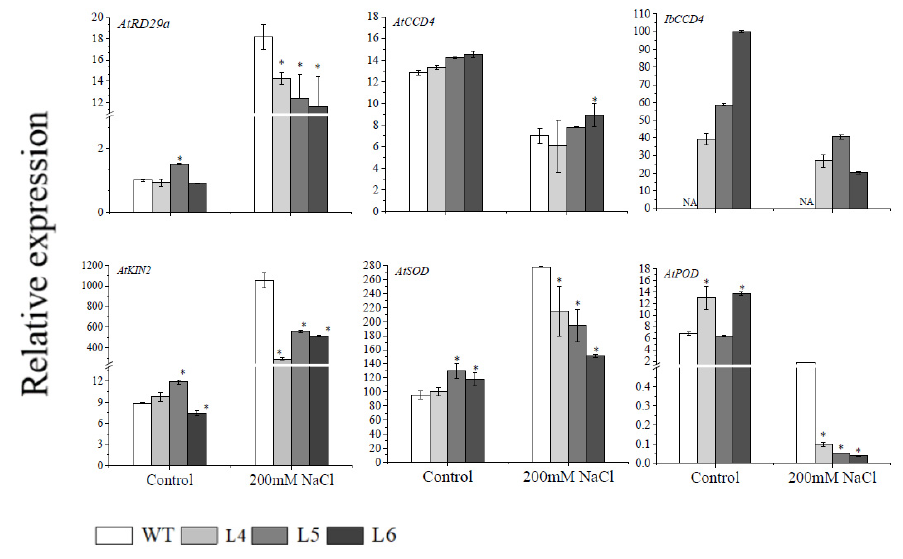
Figure 7. Transcript levels of the resistance-related genes in the transgenic Arabidopsis and WT plants under irrigation with 200 mM NaCl for 7 days. AtActin was used as an internal control. The expression of AtRD29a in WT was used as the calibration. Significant difference between L4, L5, and L6 and WT at * p < 0.05 by Student’s t -test.